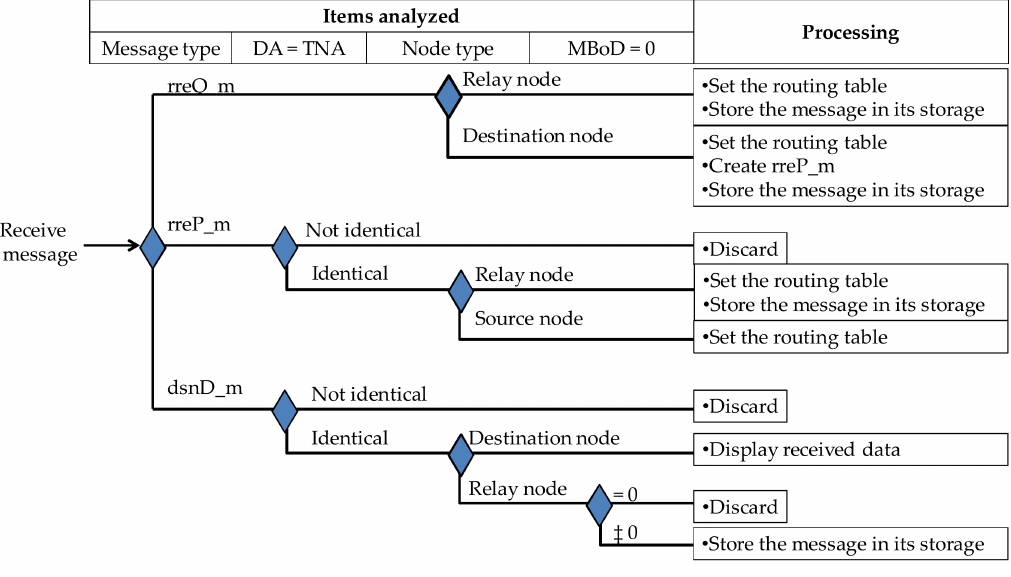
Figure 4. Analysis tree to decide whether to accept the received